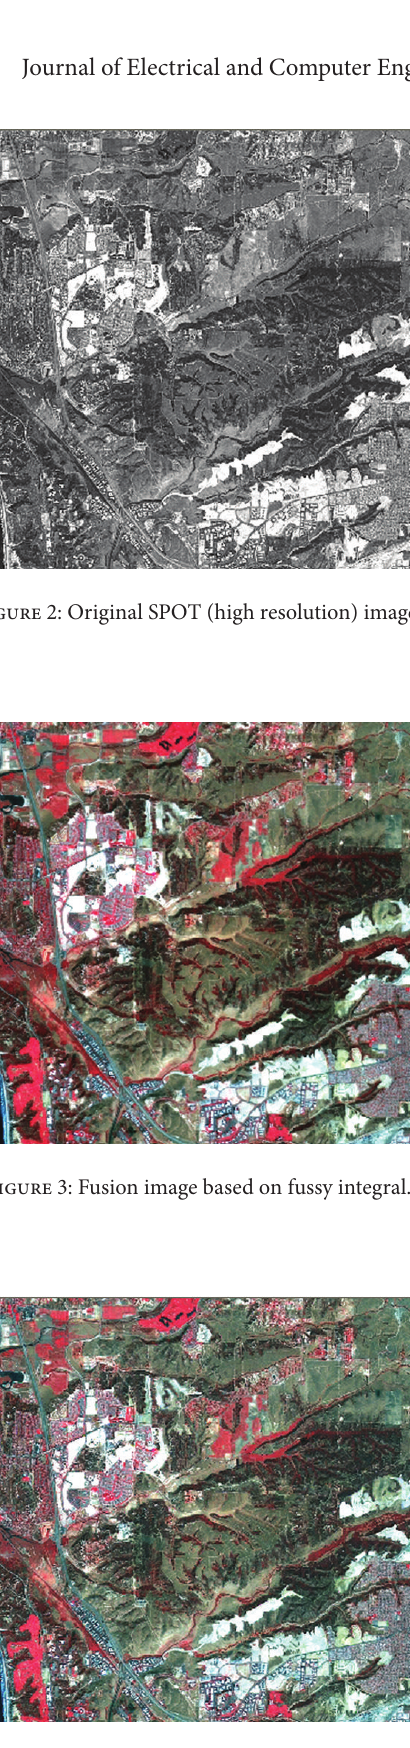
Figure 4: Image after fusion of combinatorial algorithm based on energy selection and wavelet